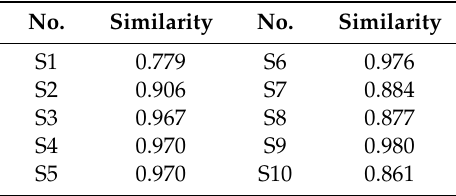
Table 2. Similarity values of 10 batches of Ranae Oviductus protein and reference chromatographic fingerprint